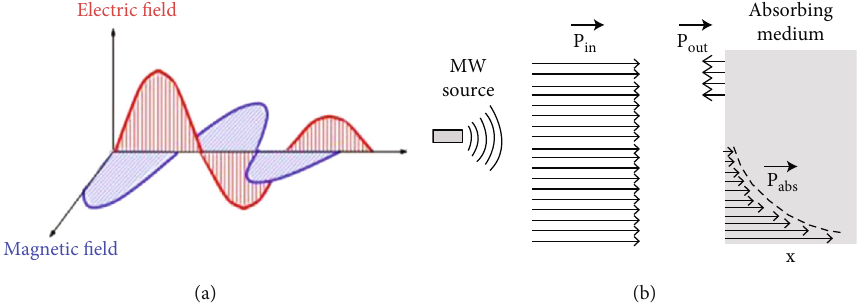
Figure 2: (a) Representation of the extenuation of a microwave propagating in absorbing medium. (b) Distribution of the power absorbed by a lossy material ( P